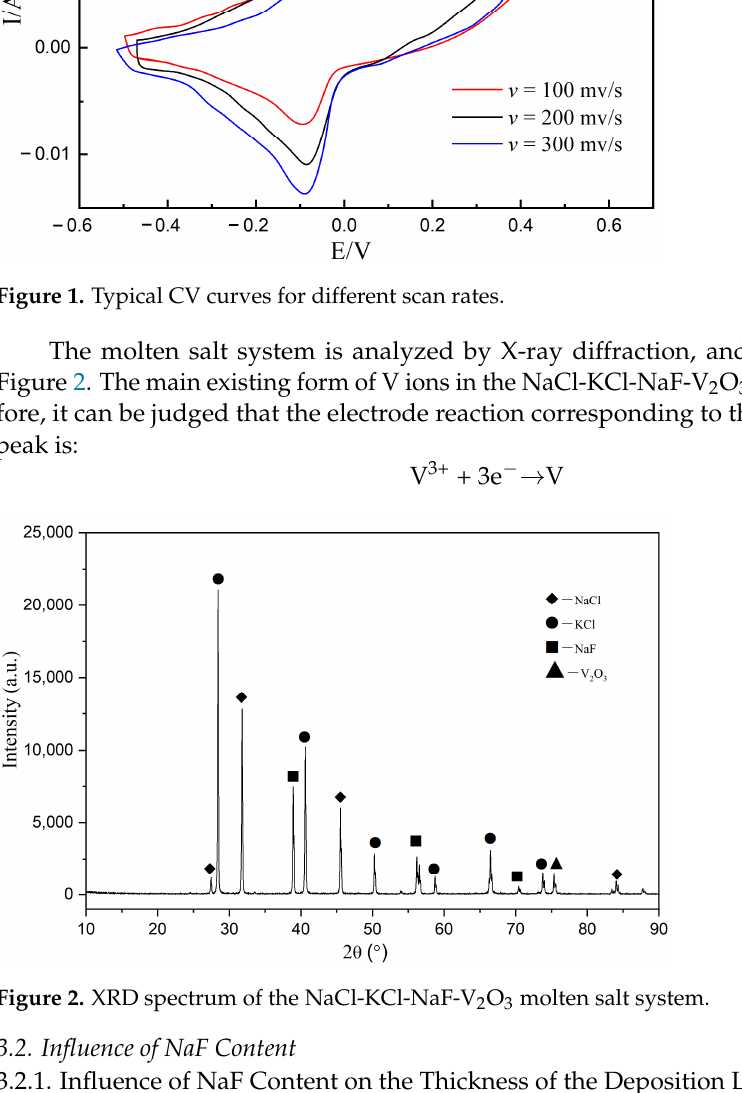
Figure 1. Typical CV curves for different scan rates.